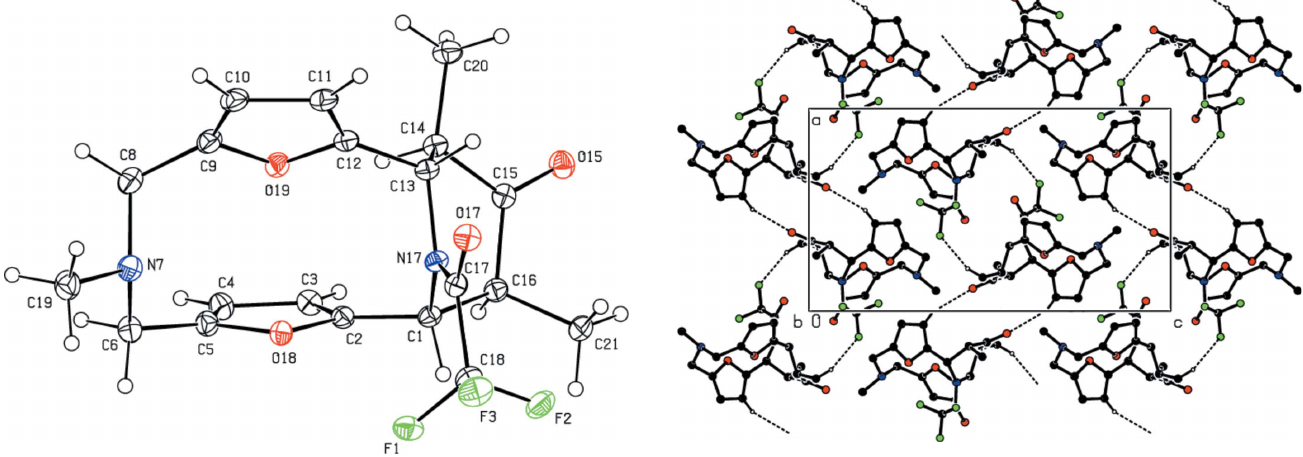
Figure 3 View down the b -axis showing the C—H (cid:3)(cid:3)(cid:3) O and C—H (cid:3)(cid:3)(cid:3) F hydrogen bonds (dashed lines).